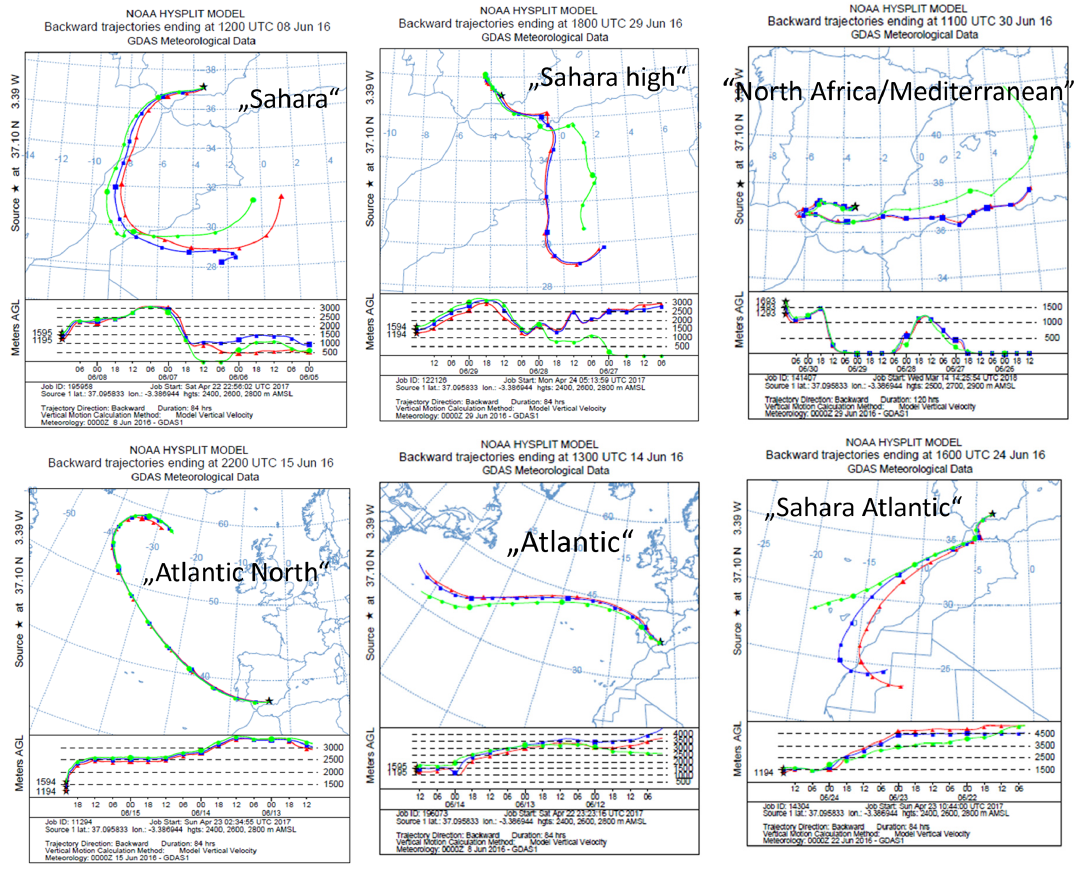
Figure 3. Back trajectories used for classification of aerosol types.